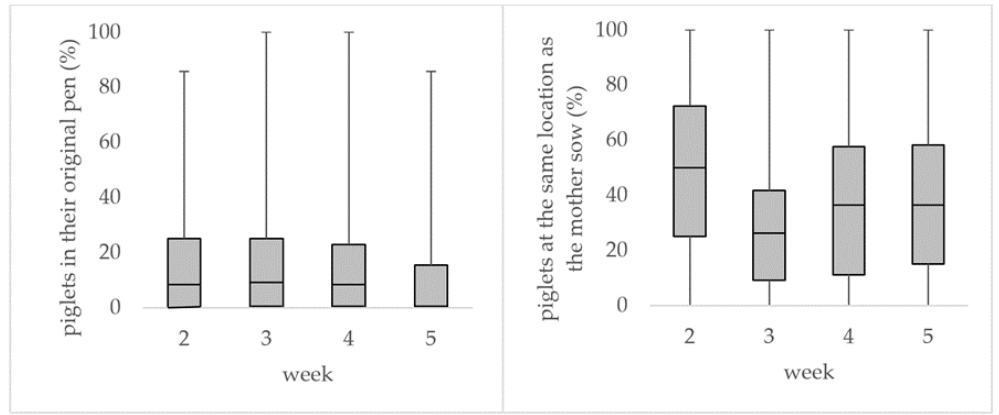
Figure 5. Percentage of piglets that were in the same pen as they were born (original pen) and that were at the same location as the mother sow, during direct observation from the 2nd to the 5th week post-partum.